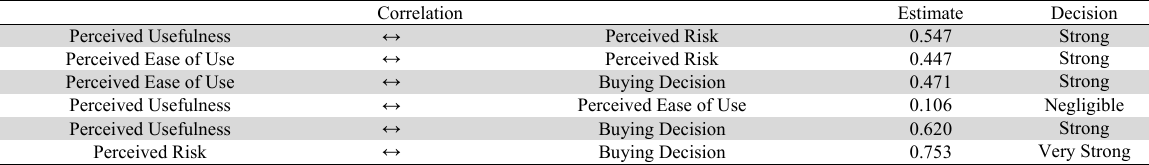
Results of Correlation Estimate (CFA 4 th factors structures) Correlation